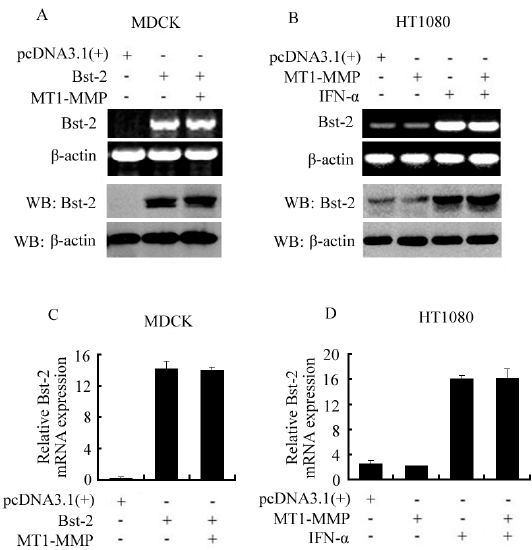
Figure 2. Effect of MT1-MMP on the expression of Bst-2 in mRNA and protein levels HT1080 and MDCK cells. Cells were divided into two parts and seeded in 6-plates overnight, then transfected with plasmids as shown in figures; 48 h after transfection, ( A , B ) one part of the cells was treated with TRIZOL for RT-PCR assay and lysed with lysis buffer for western-blot assay; ( C , D ) the other part of the cells was treated with TRIZOL and harvested for qPCR as described in “Materials and Methods”.